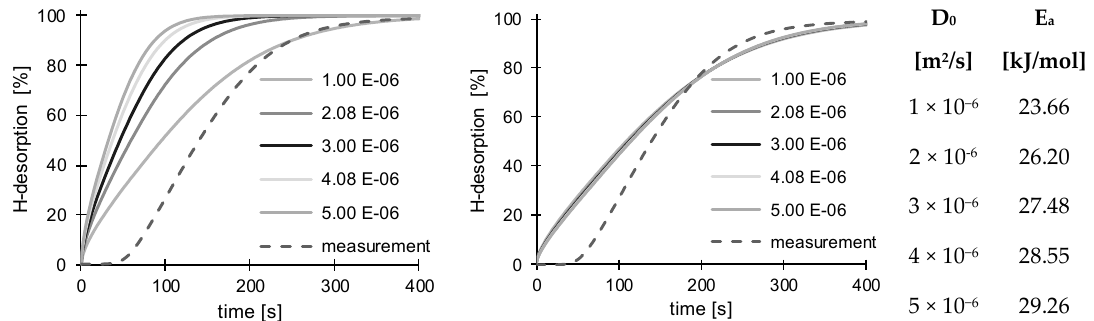
Figure 19. The procedure of the iteration.